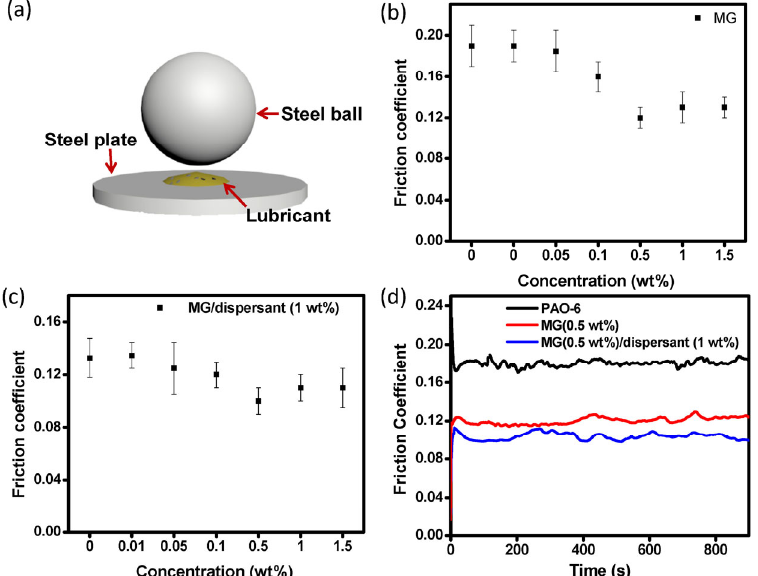
Fig. 3 (a) Schematic diagram of frictional experiments, the variation of friction coefficient with the change of concentration for (b) MG and (c) MG/dispersant, and (d) friction curves of PAO-6, MG (0.5 wt%) and MG (0.5 wt%)/dispersant (1